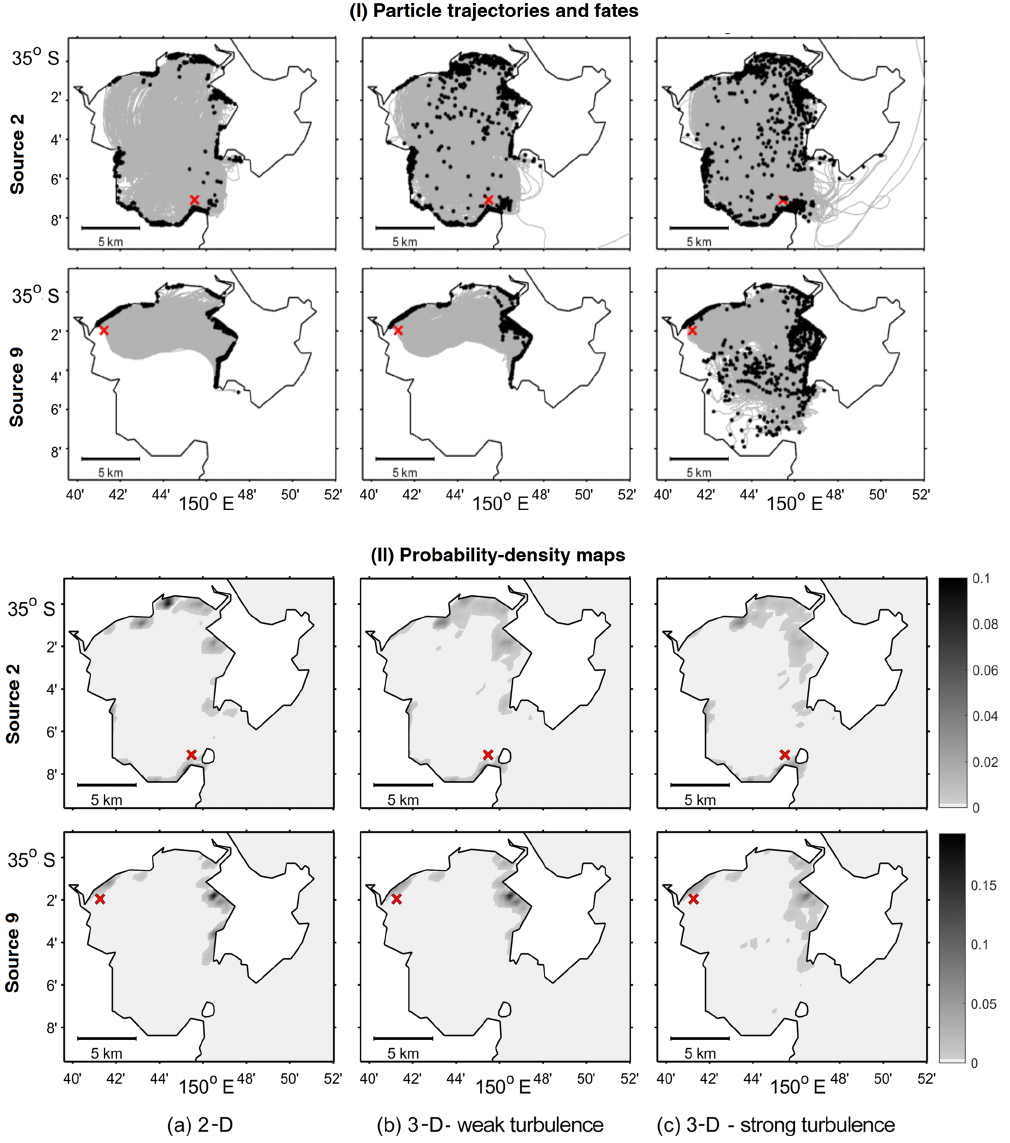
Figure 2. (I) Trajectories (grey lines), fate (black dots) and (II) probability-density distribution (greyscale bar) of microplastics released at sources 2 and 9 (red crosses) after 5d of simulation for the three different scenarios: (a) 2-D approach; (b) 3-D approach with weak vertical turbulence; (c) 3-D approach with strong vertical